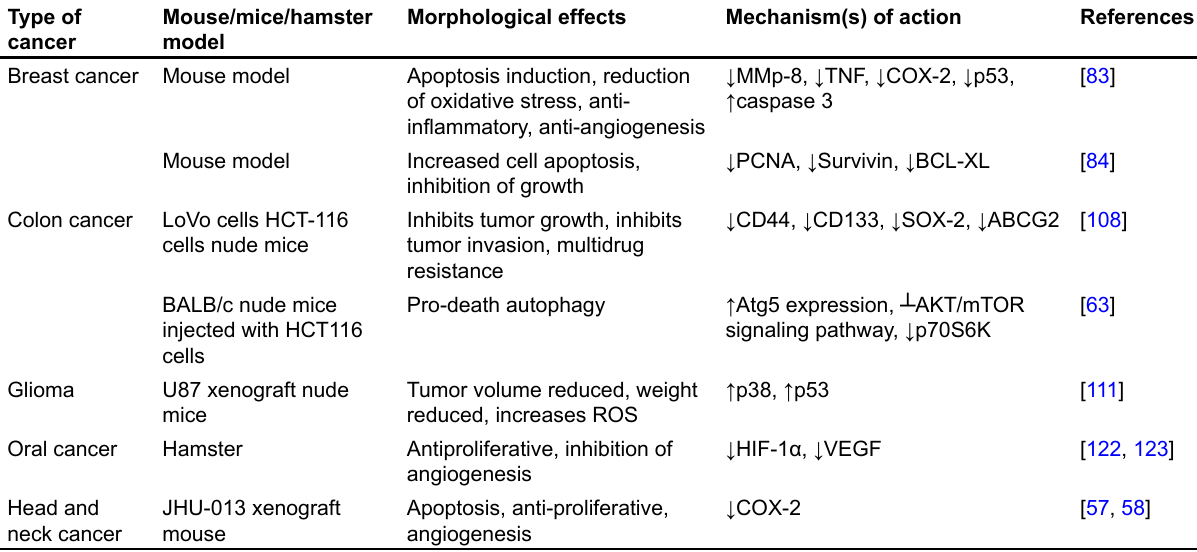
↑ increases expression, ↓ decreases expression Table 2. Selected in vivo anticancer effects of SAB Type